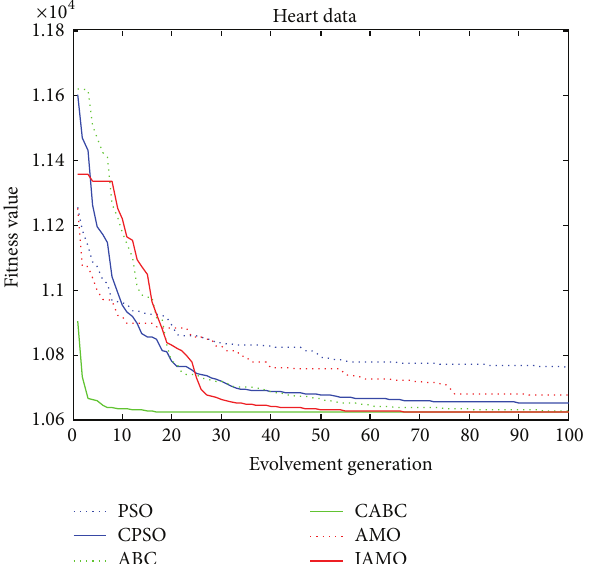
Figure 13: The convergence curve of the balance scale data.